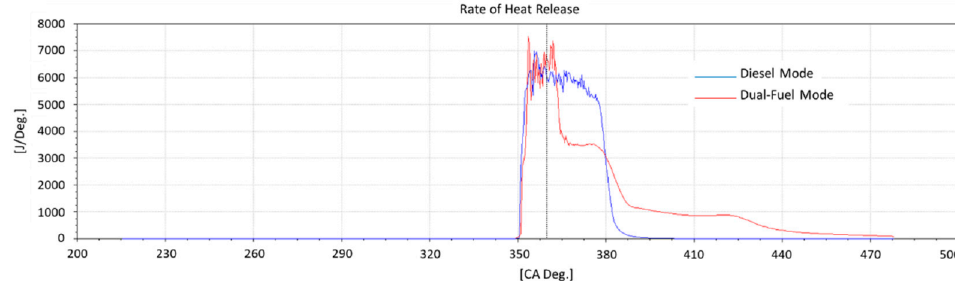
Figure 9. The rate of heat release diagrams.